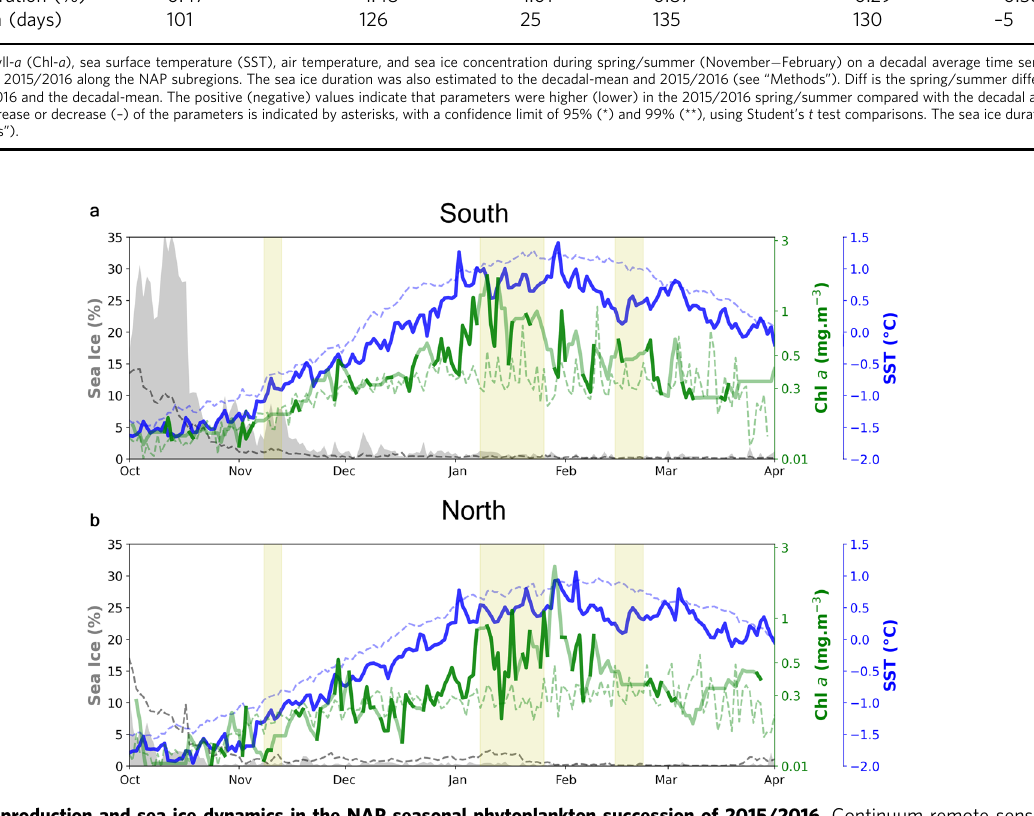
Fig. 2 Biological production and sea ice dynamics in the NAP seasonal phytoplankton succession of 2015/2016. Continuum remote sensing measurements of chlorophyll-a (Chl- a ; solid green line), sea surface temperature (SST; solid blue line), and sea ice concentration (gray area) along the NAP, in south ( a ) and north ( b ) subregions during spring/summer of 2015/2016. The dashed green, blue and gray lines indicate the decadal average (2010 – 2019) of Chl- a , SST, and sea ice concentration, respectively. The solid light green lines represent the Chl- a interpolated values. The background shades show the in situ data sampling periods. It is important to note that Chl- a remote sensing data in Antarctic coastal waters are typically underestimated in respect to in situ Chl- a data (see Supplementary Fig. 1) 12,29